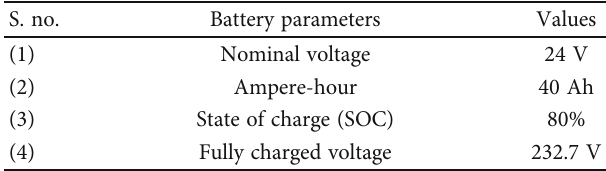
Table 1: Battery speci fi cations.